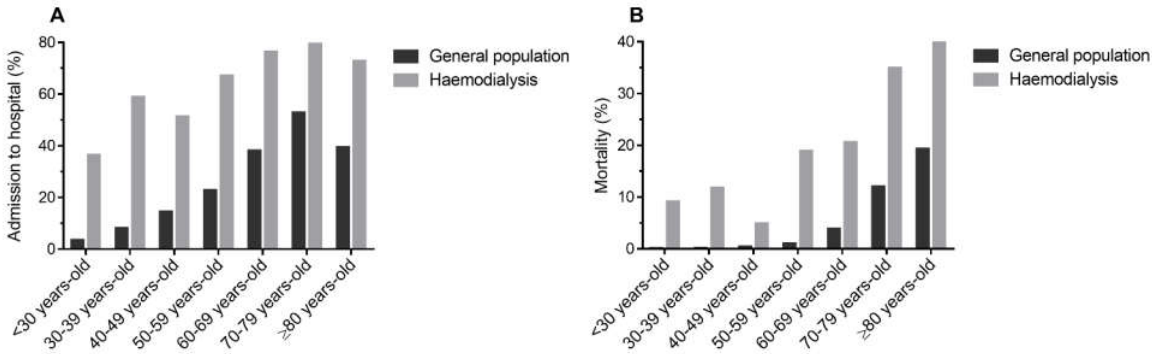
Figure 3. Hospitalization and mortality in Spanish general population and haemodialysis patients with COVID-19. ( A )